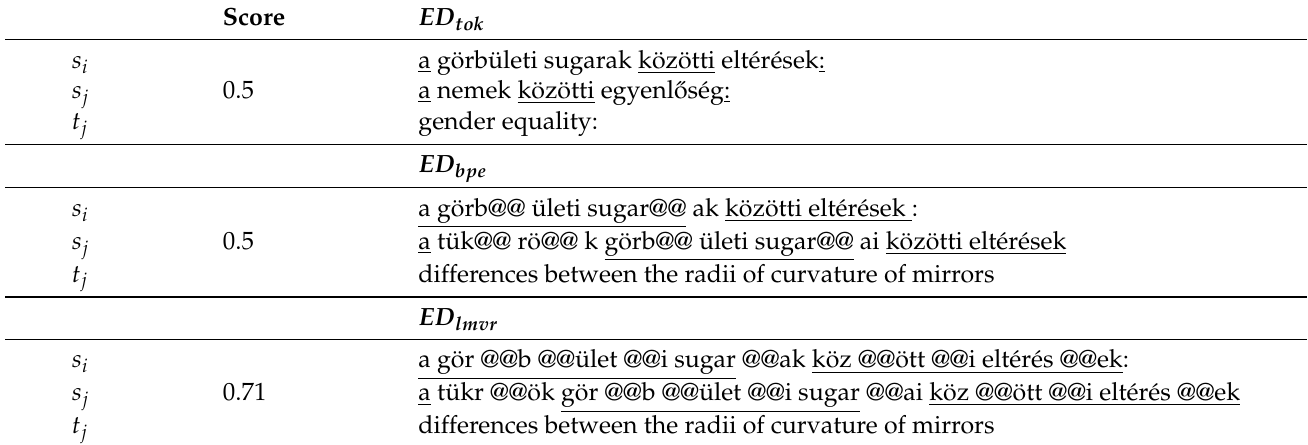
Table 1. Best fuzzy matches retrieved with edit distance using word tokens, byte-pairs and LMVR tokens for the Hungarian input sentence ‘a görbületi sugarak közötti eltérések:’, with the English translation ‘differences between the radii of curvature:’. Matching (sub)word tokens between the input source ( s i ) and the best fuzzy match source/target pair ( s j , t j ) are